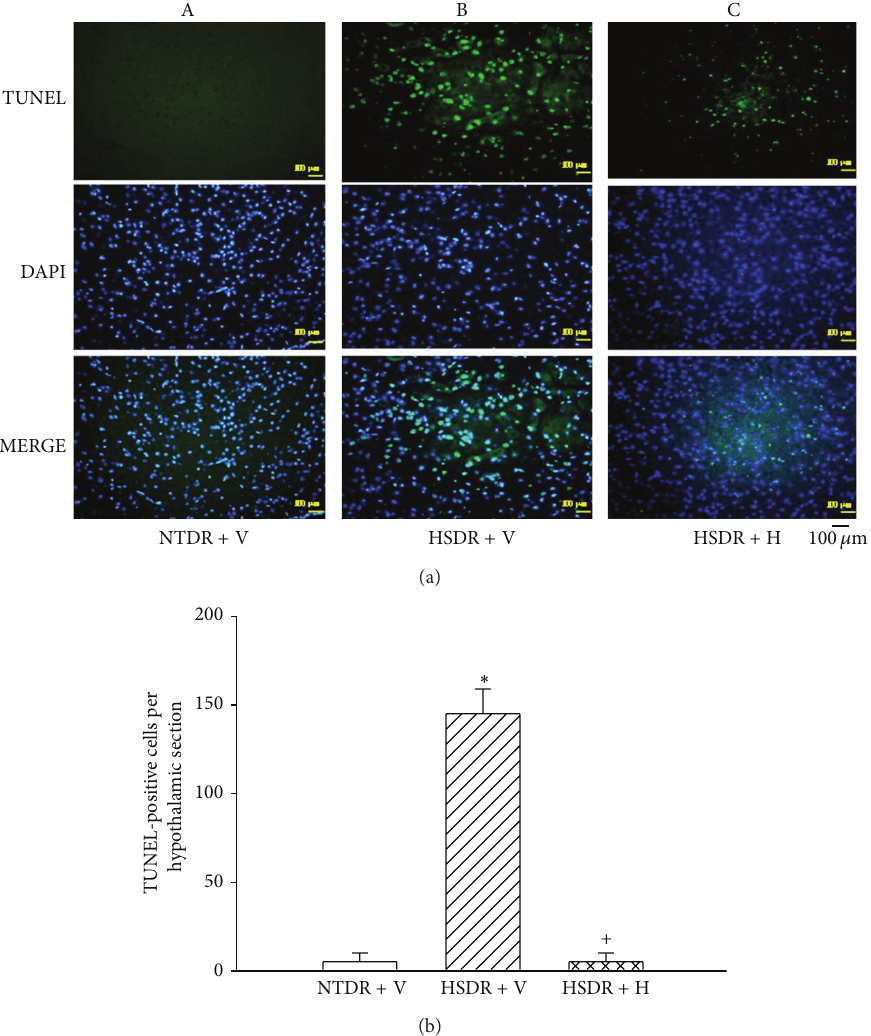
Figure 4: Values of hypothalamic TUNEL-positive cells for the (NTDR + V) group (white bar), (HSDR + V) group (dashed bar), and (HSDR + H) group (crossed bar). The values were obtained at 60 min after the initiation of heat exposure in heatstroke rats or the equivalent times in the (NTDR + V) group. ∗ 𝑃 < 0.01 in comparison with the (white bar) group; + 𝑃 < 0.01 in comparison with (dashed bar) group. Bars were each the mean ± SD of eight rats of reach group. Top panels depict the representative photographs for TUNEL staining in a (NTDR + V) rat, a (HSDR + V) rat, and a (HSDR + H) rat. See the legends of Figure 1 for the